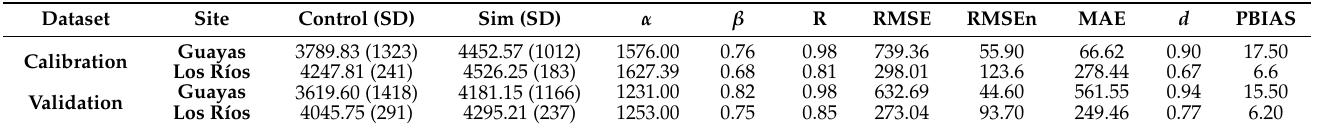
Table 1. Evaluation results for VSM yield simulations over the entire growing season for calibration and validation datasets for Guayas and Los Ríos Provinces.